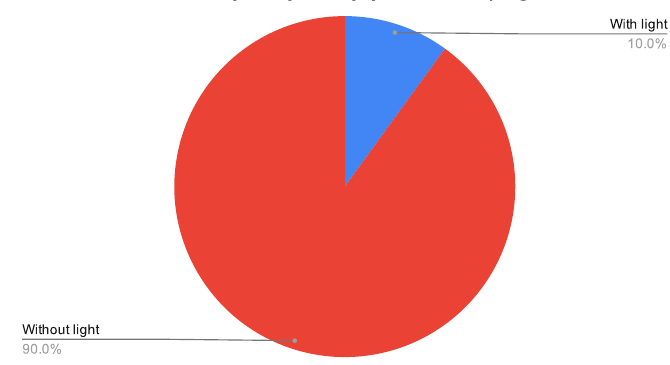
Figure 11. Exposure to Light After